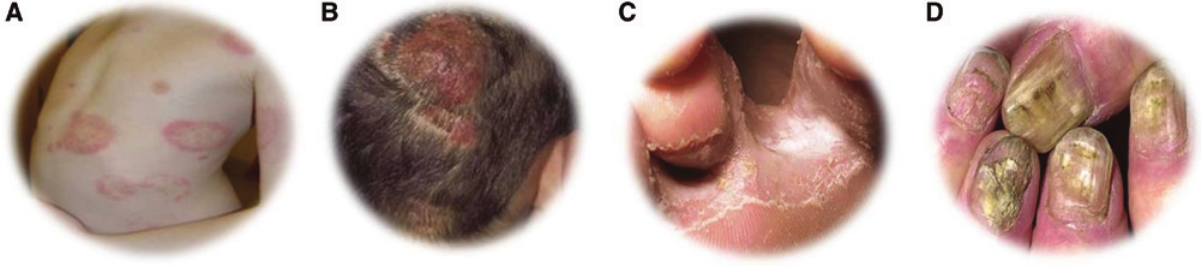
Figure 1: Different forms of dermatophytoses: (A) Tinea corporis, (B) Tinea capitis, (C) Tinea pedis, (D) Tinea